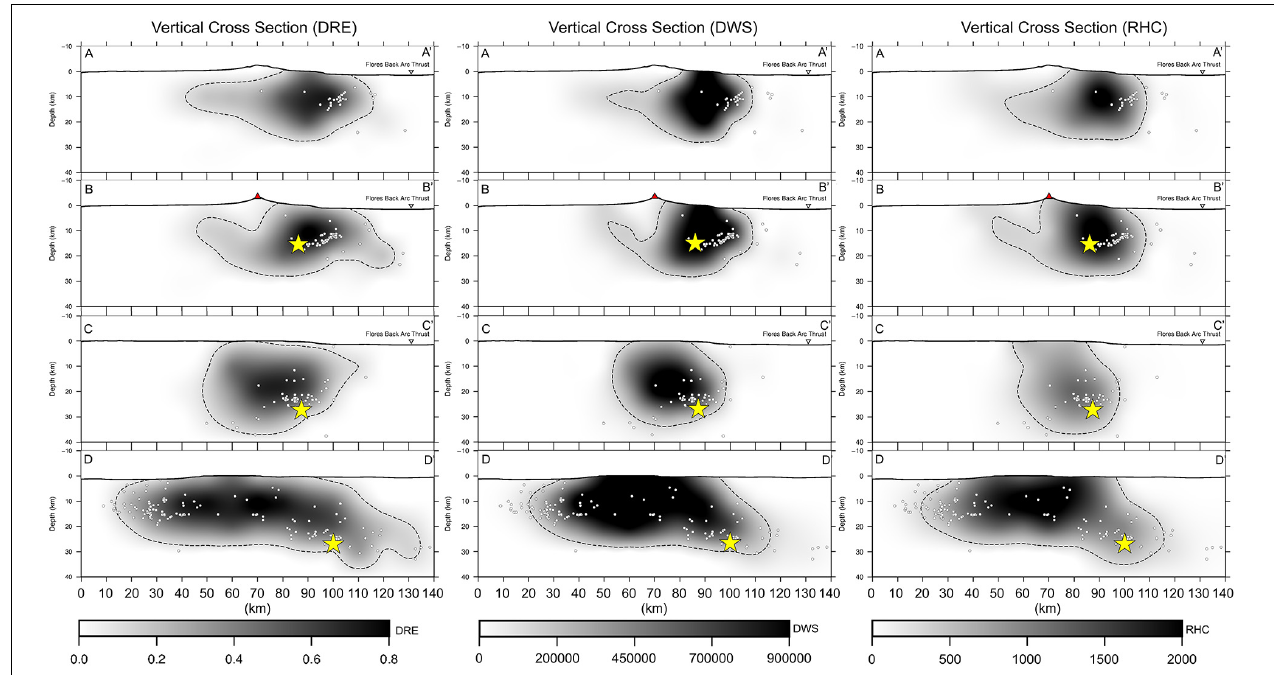
FIGURE 6 | Resolution test results along cross-sections AA (cid:48) , BB (cid:48) , CC (cid:48) to DD (cid:48) (see Figure 3A ) of the Diagonal Resolution Element (DRE), Derivative Weight Sum (DWS) and, Ray Hit Count (RHC) for Q p . Black and white colors indicate high and low values; white circles are the hypocenters.